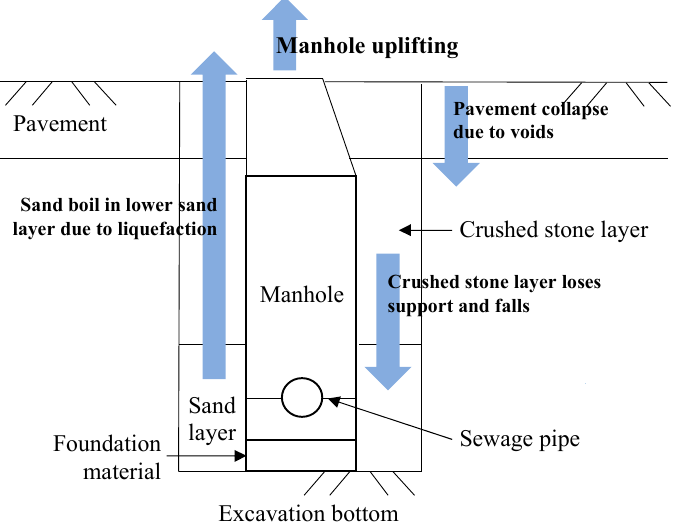
Figure 3. Mechanism of occurrence of manhole uplifting due to earthquake.